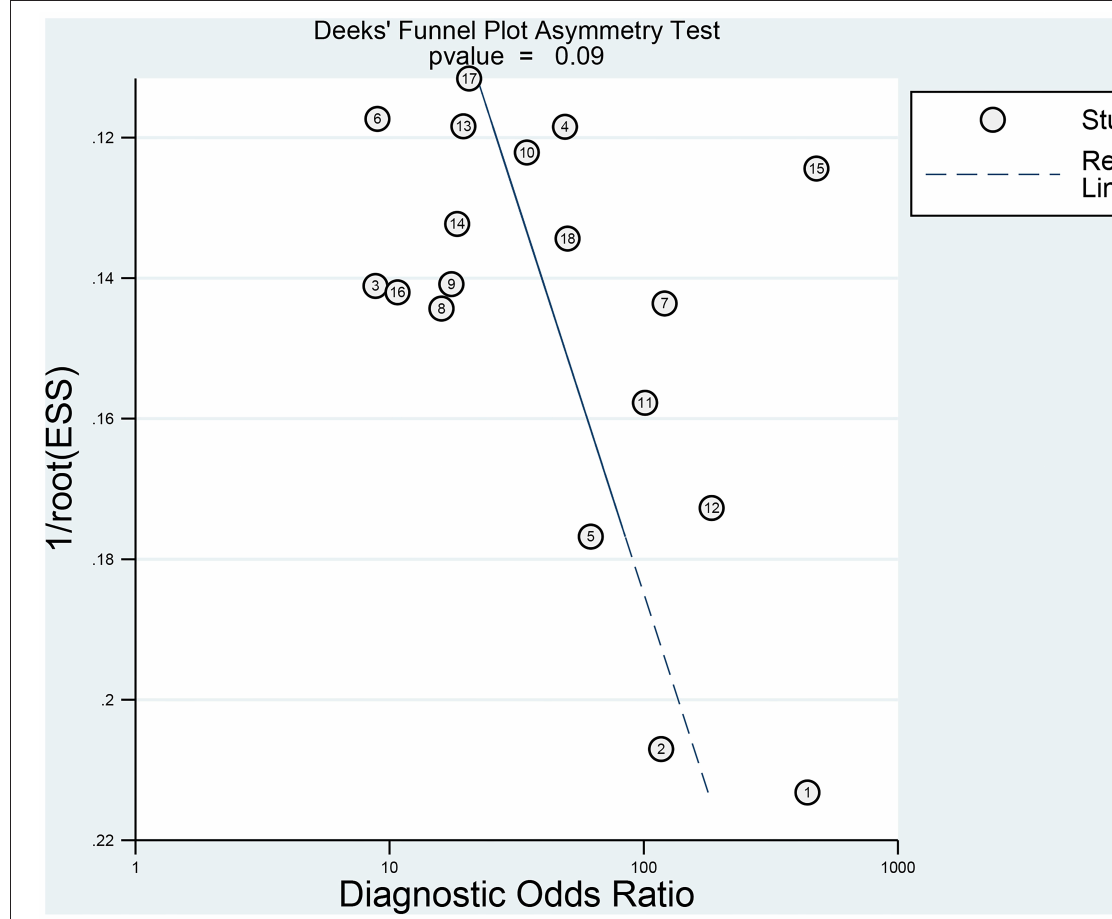
FIGURE 7 | Publication bias determined by conducting Deeks’